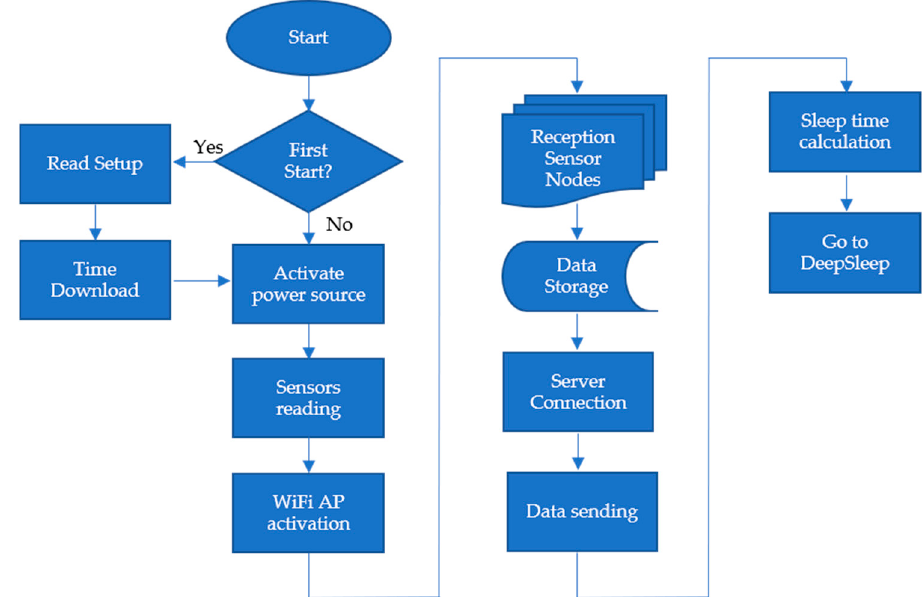
Figure 7. The general operation of Gateway node.